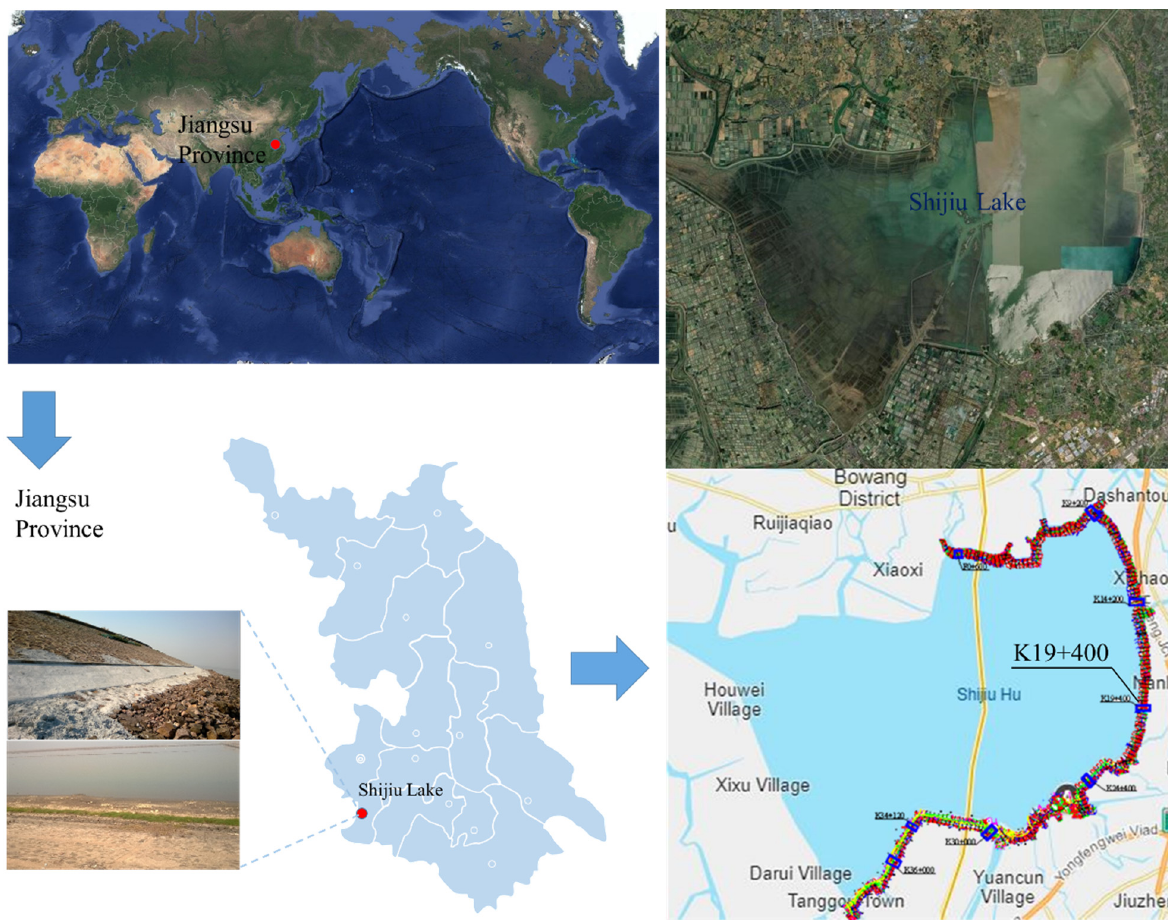
Figure 2. Location of Shijiu Lake.